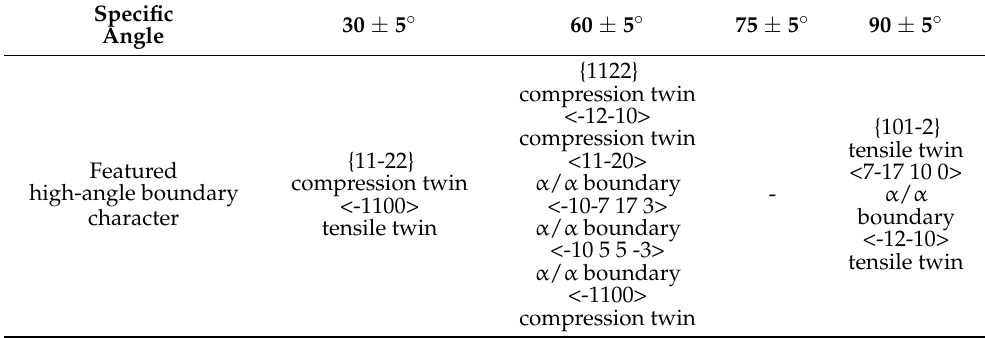
Table 1. Featured high angle boundary characters of CP-Ti of near 30 ◦ , 60 ◦ , 75 ◦ , and 90 ◦